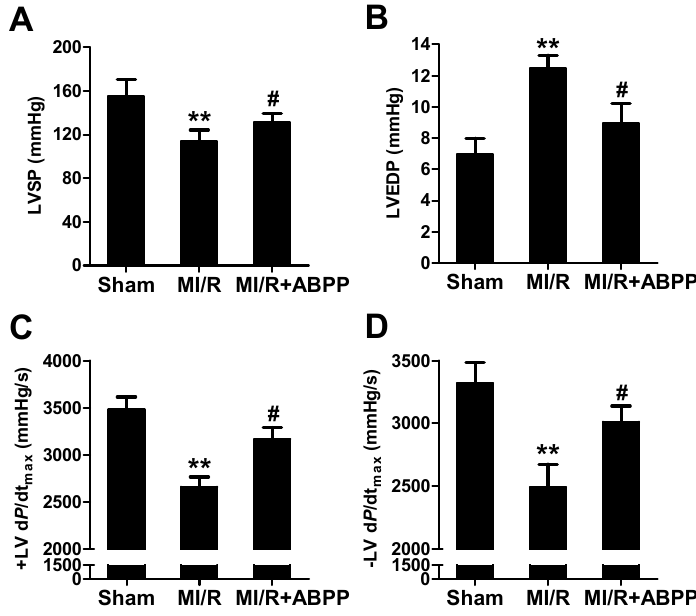
Figure 1. Achyranthes bidentata polypeptides (ABPP) preconditioning increased cardiac functions in rats subjected to myocardial ischemia/reperfusion. ( A ) LVSP, left ventricular systolic pressure; ( B ) LVEDP, left ventricular end diastolic pressure; ( C ) +LV d P /d t instantaneous first derivation of left ventricle pressure; ( D ) − LVdP/d t ischemia/reperfusion (30 min/4 h); Sham, sham-operated; ABPP, Achyranthes bidentata polypeptides. Values presented are means ± SEM. n = 8/group. ** p < 0.01 versus